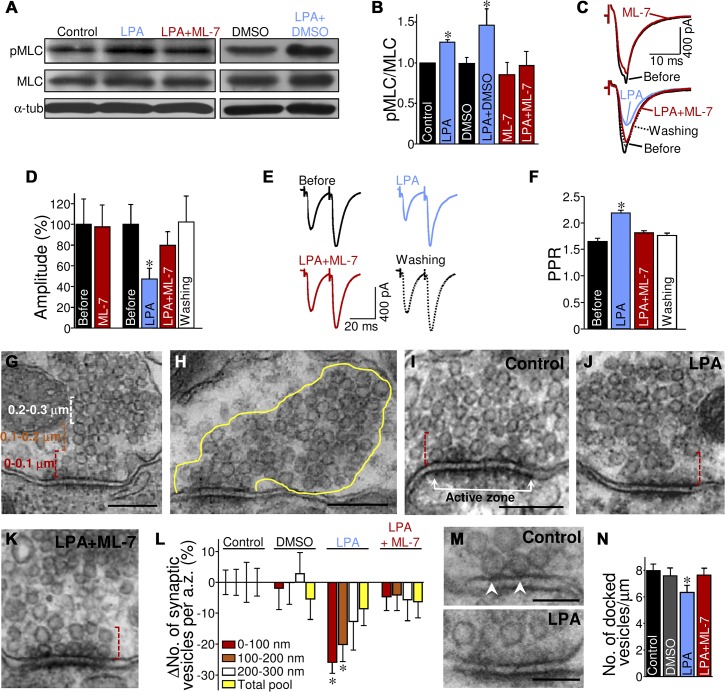
LPA rearranges SVs at excitatory boutons in a MLCK-dependent manner.(A) Western blot of phosphorylated and total MLC protein levels (denoted as pMLC and MLC, respectively) in the HN of neonatal brain stem slices incubated for 10 min in aCSF alone (control) or supplemented with either LPA (2.5 μM), vehicle (0.2% DMSO), LPA + vehicle, or LPA + ML-7 (10 μM). α-tubulin (α-tub) expression was the internal loading reference. (B) Histogram showing the average ratio of pMLC to total MLC densitometric intensity for the control and treated slices. Ratio values were normalized relative to the control group. Columns represent the average of at least three independent experiments. *p < 0.05, one-way ANOVA on Ranks relative to control condition. (C) eEPSCsAMPA recorded from two HMNs in normal aCSF and after 10 min bath perfusion with the indicated combination of drugs. (D) Average eEPSCAMPA amplitude for the ML-7 (n = 5 HMNs) and LPA+ML-7 (n = 7 HMNs) treated groups of HMNs compared with their respective pretreatment controls (before). (E) eEPSCsAMPA evoked in HMNs by paired-pulse stimulation of VLRF before and following treatment with LPA and finally after coaddition of ML-7. (F) Changes in PPR of eEPSCsAMPA measured in HMNs exposed sequentially to LPA and LPA+ML-7. *p < 0.05, one-way RM-ANOVA relative to the control condition in D and F. (G, H) Electron micrographs of two S-type boutons (containing spherical vesicles) with asymmetric synaptic contacts on the somatic membrane of a HMN depicting details of the procedure used to examine topographically the numerical changes in SVs. The number of SVs was counted in three zones, each 0.1 μm wide, parallel to the membrane of the synaptic cleft and at successively greater distances from the a.z. (G). The first region (red dashed line) encloses an area directly adjacent to the a.z. membrane. The intermediate region (orange dashed line) was located in the interval from 0.1 μm to 0.2 μm away from the a.z. Finally, the more distant region (white dashed line) occupied an area corresponding to the distance interval from 0.2 μm to 0.3 μm. The total number of SVs contained in each bouton section was also quantified (H). (I–K) Electron micrographs of S-type boutons in contact with the somatic membrane of HMNs from neonatal rats following incubation (10 min) of brain stem slices in aCSF alone (control) or supplemented with LPA or LPA+ML-7 at concentrations indicated in A. The boxed region (red dashed line) encloses the area directly adjacent to the a.z. membrane. (L) Quantitative changes in the number of SVs (expressed as percentage change from control) are shown in each spatial compartment. Histogram bins indicate distances from the a.z. as indicated in the legend. Increment in the number of the total pool of SVs per bouton section is also illustrated (yellow bars). (M) High-magnification electron microscopy images showing in detail the SVs (membranes in contact with the presynaptic density) docked to the a.z. (arrowheads). Scale bars: G–K, 200 nm; M, 100 nm. (N) Histogram showing the linear density of docked SVs per μm of a.z. under the indicated conditions. Control, n = 133 boutons/a.z.; vehicle, n = 54/104 boutons/a.z.; LPA, n = 102 boutons/a.z.; LPA plus ML-7, n = 102 boutons/a.z. *p < 0.05, one-way ANOVA relative to the control condition. Experiments and analysis were performed as in our previous published study [8]. Plots data can be found in S1 Data.